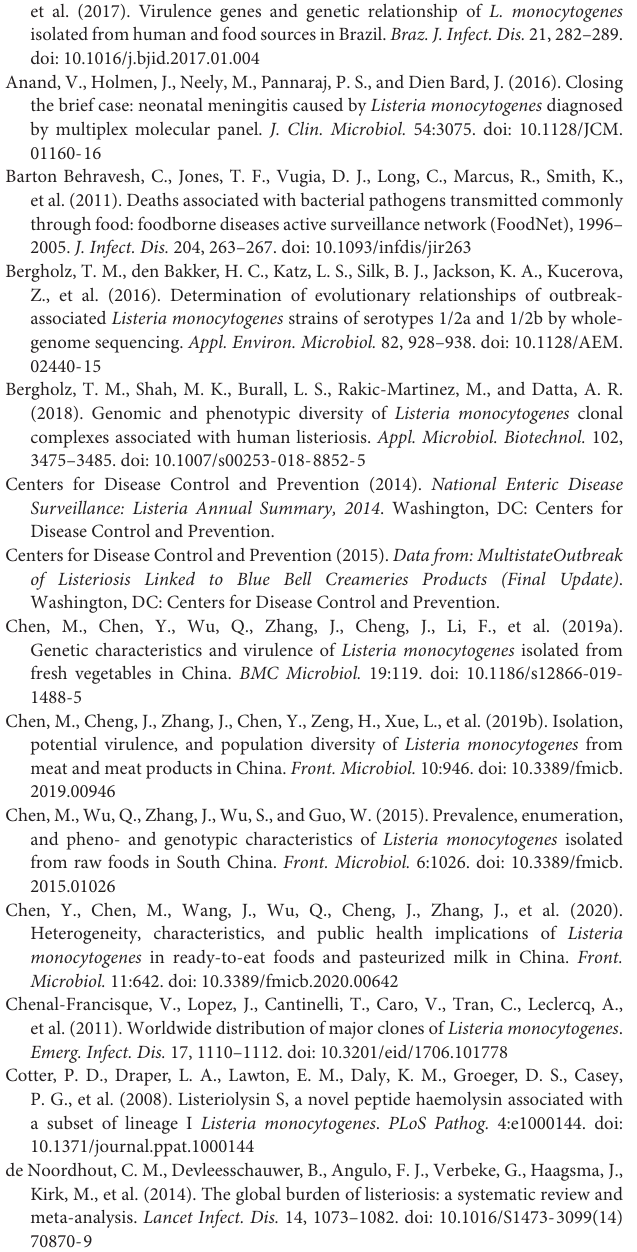
between a pair of neighboring isolates. Each circle represents a MLST type (ST) and the STs of the isolates were colored as shown in figure. The size of the circle is proportional to the number of the isolates. The shadow zones in different color represent different complexes. Supplementary Figure 2 | Comparison cgMLST analysis with wgSNP carried on the 86 isolates. Numbers on the branch represent the alleles distance. A